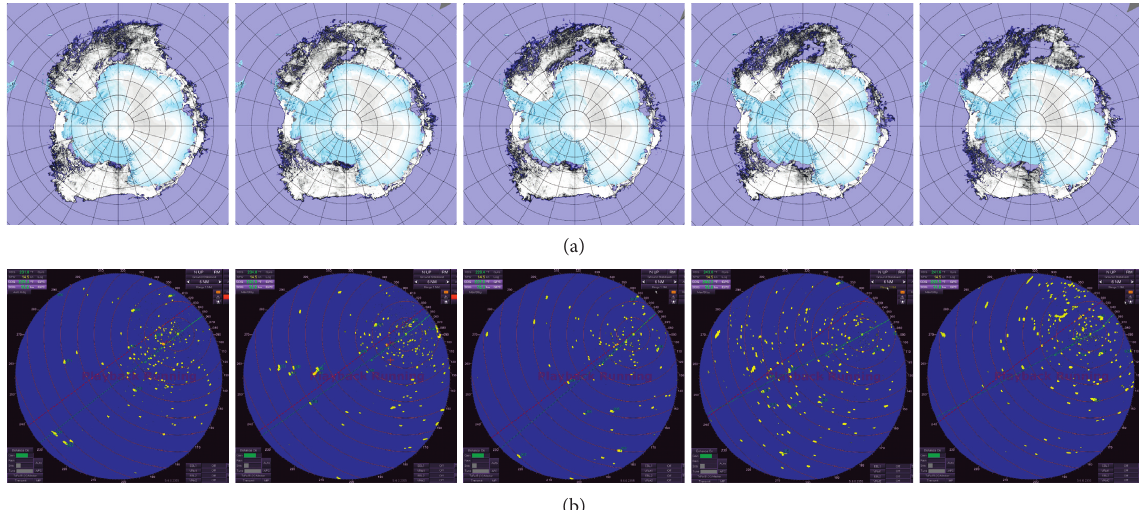
Figure 10: Typical images for sea-ice concentration data and radar echoes. (a) Sea-ice concentration data. (b) Radar echo